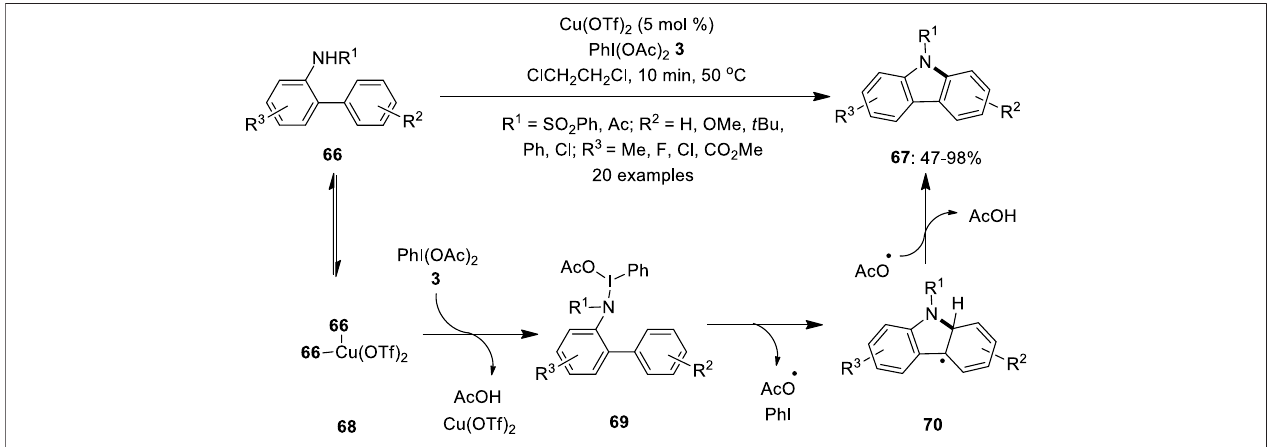
FIGURE 11 | Copper-catalyzed intramolecular cyclization of N -substituted amidobiphenyls 66 using PhI(OAc) 2 3 as an oxidant.